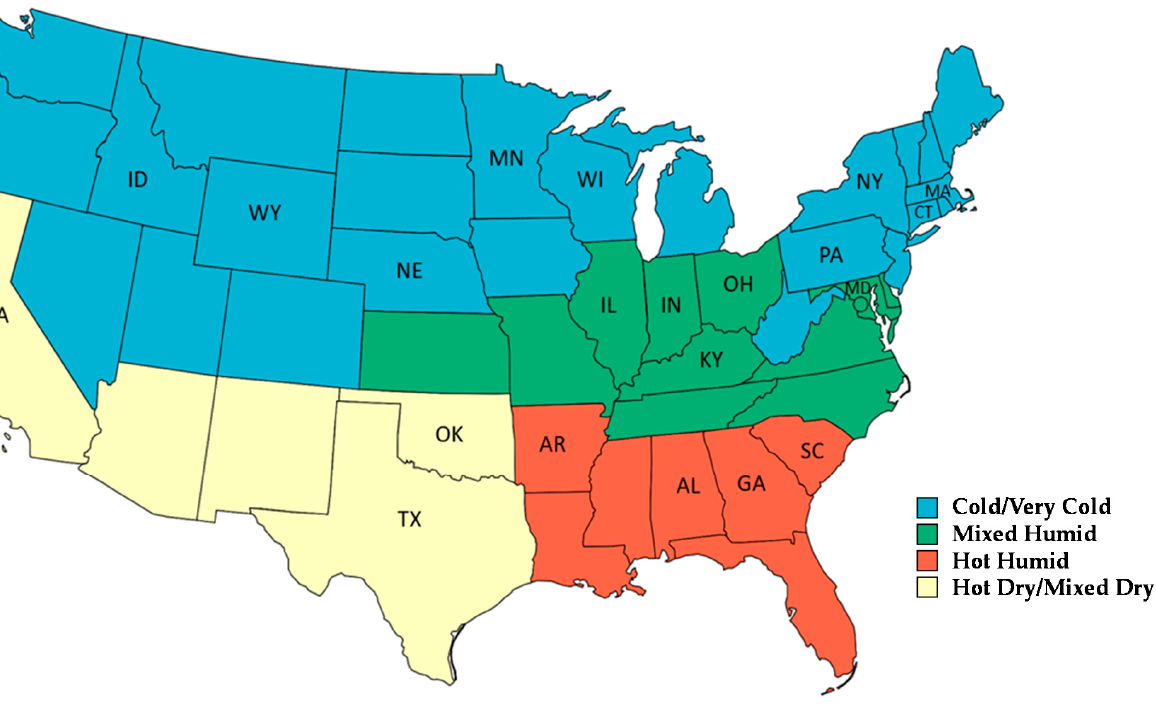
Figure 2. Climate designation and states in which facilities were located. Table 2. Seasonality of Equine Assisted Services offered by climate designation.